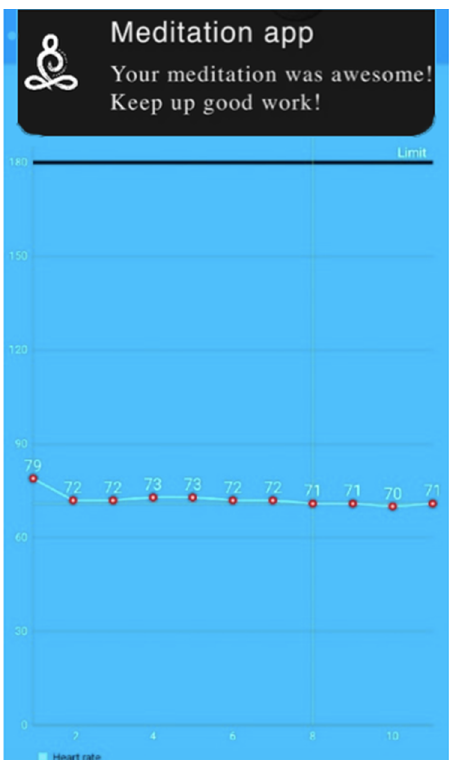
Figure 27. Example of the gamification element in application.